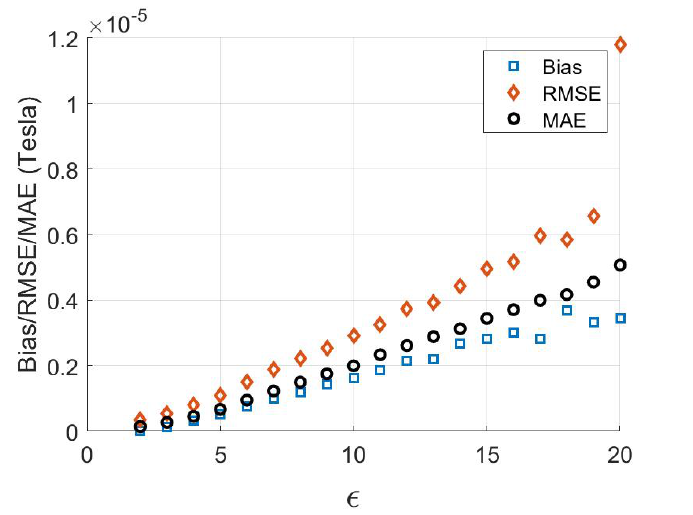
Figure 21. Bias, MAE and RMSE of the estimated magnetic field for 1st maneuver.